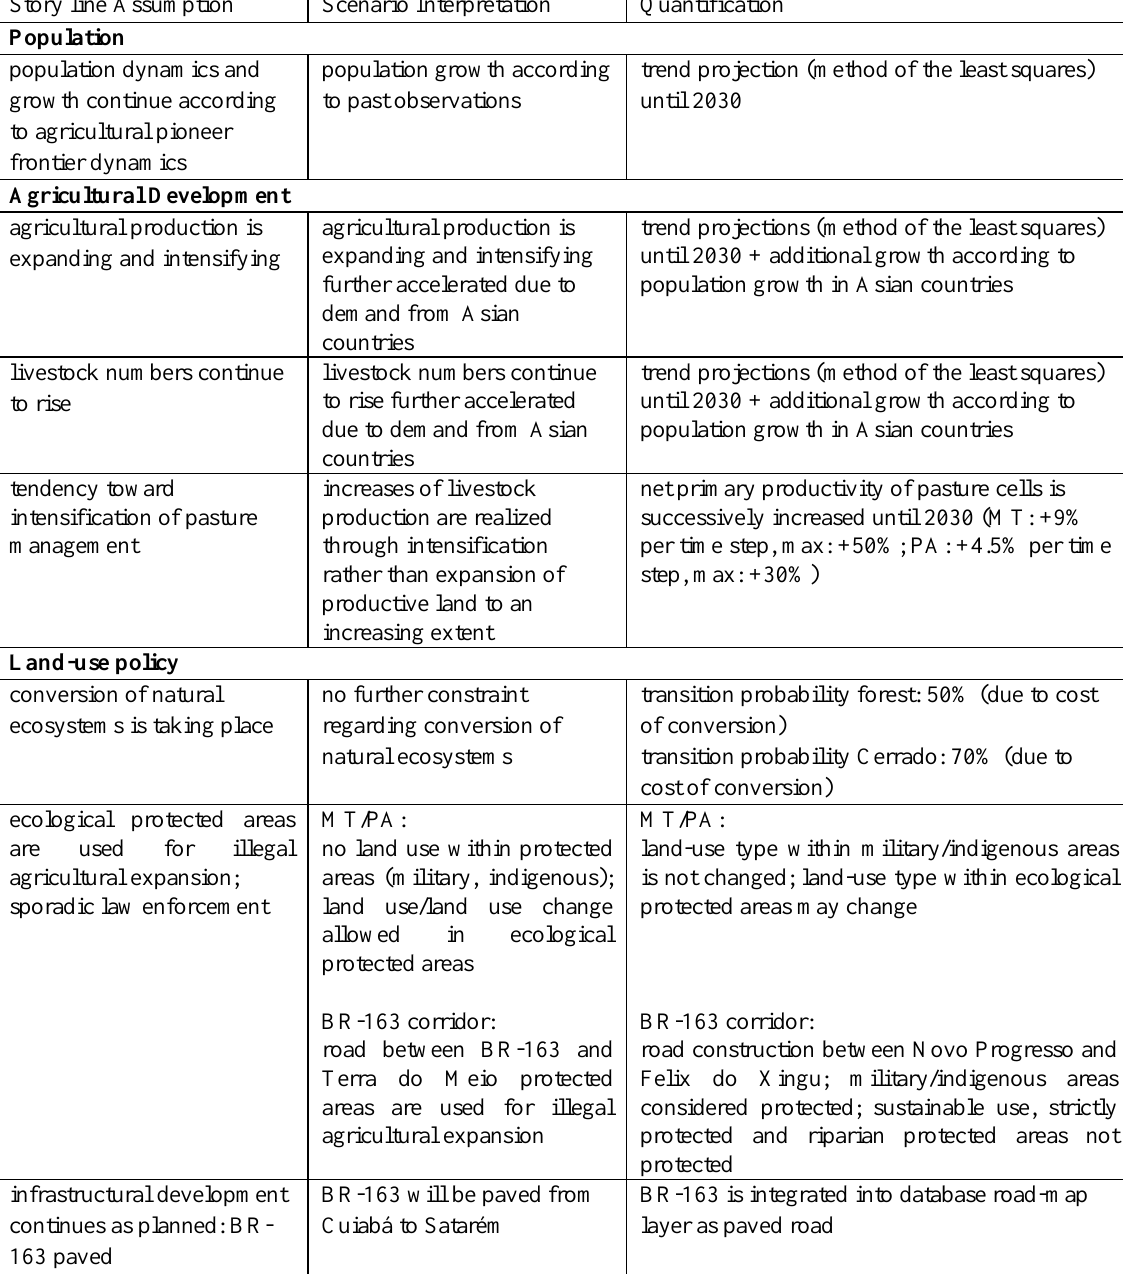
Table A1.3. Translation of story line statements to model drivers (Illegal Intensification